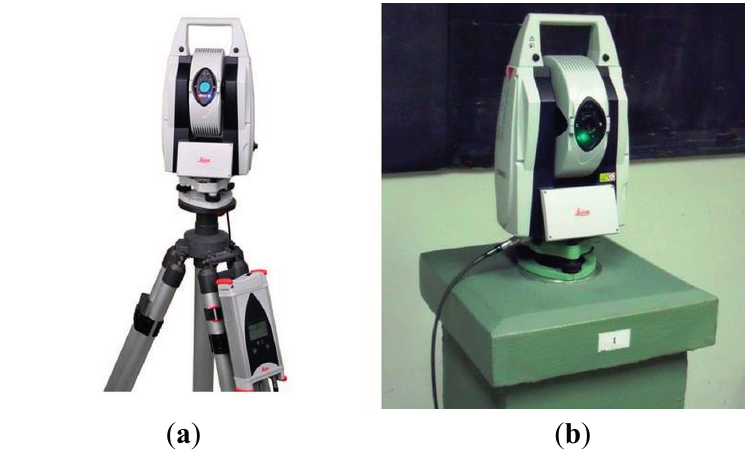
Figure 1. Leica absolute tracker AT401: ( a ) the tracker at a tripod; ( b ) the tracker at the pillar no. 1 in